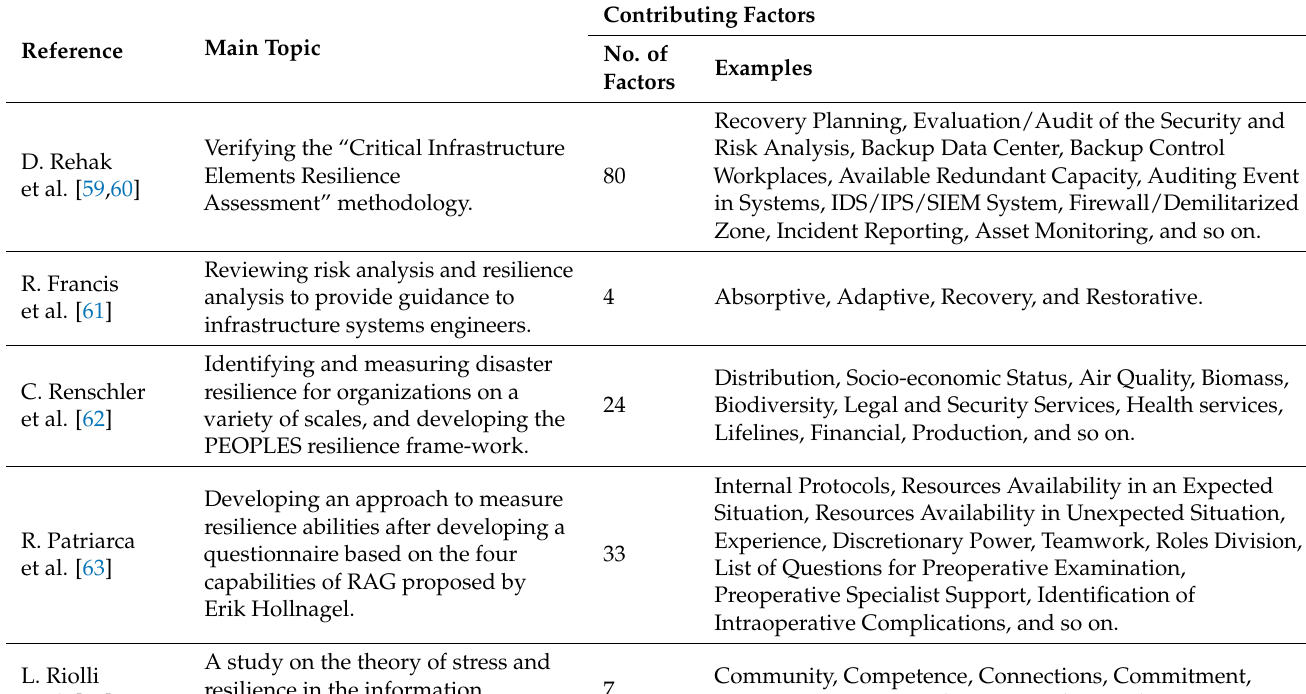
Table 6. Summary of identified contributing factors from the infrastructure